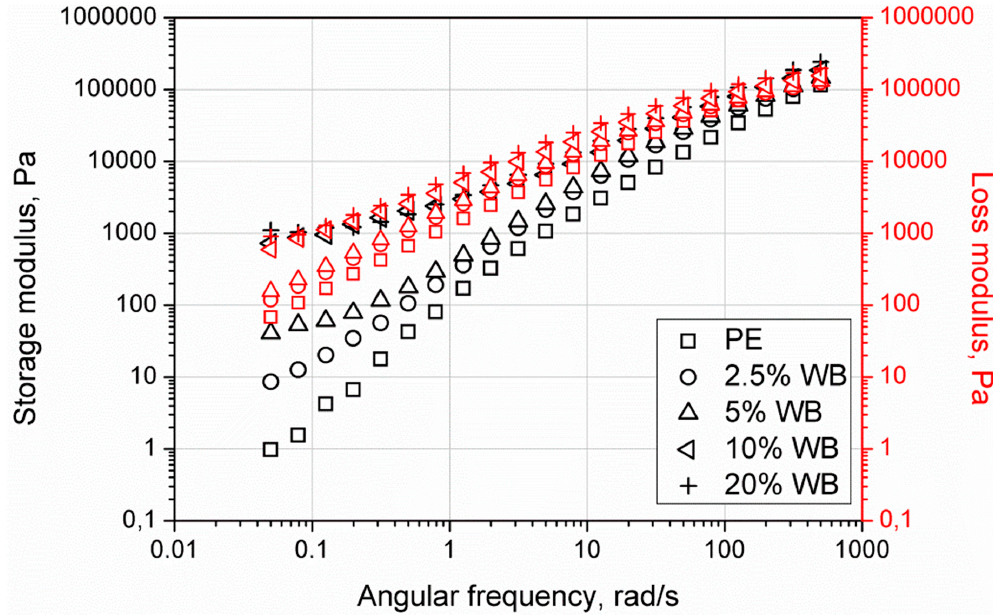
Figure 13. Storage and loss modulus vs. angular frequency curves of rotationally molded PE and PE-WB composites.